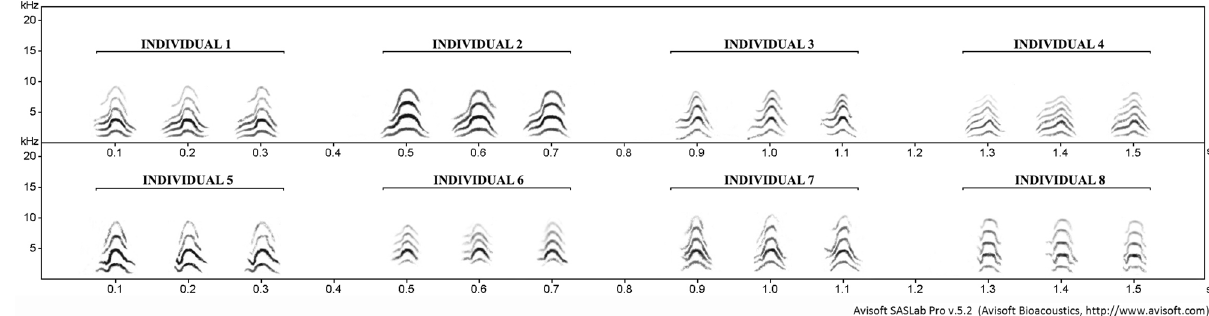
Figure 1. Between-individual differences of Call-1 produced by 8 different individuals. Individuals 1–4 (in upper row) are males and individuals 5–8 (in bottom row) are females. To show the consistency of Call-1 produced by the same individual three examples of Call-1 extracted from the same bird are presented for each individual. Acoustic